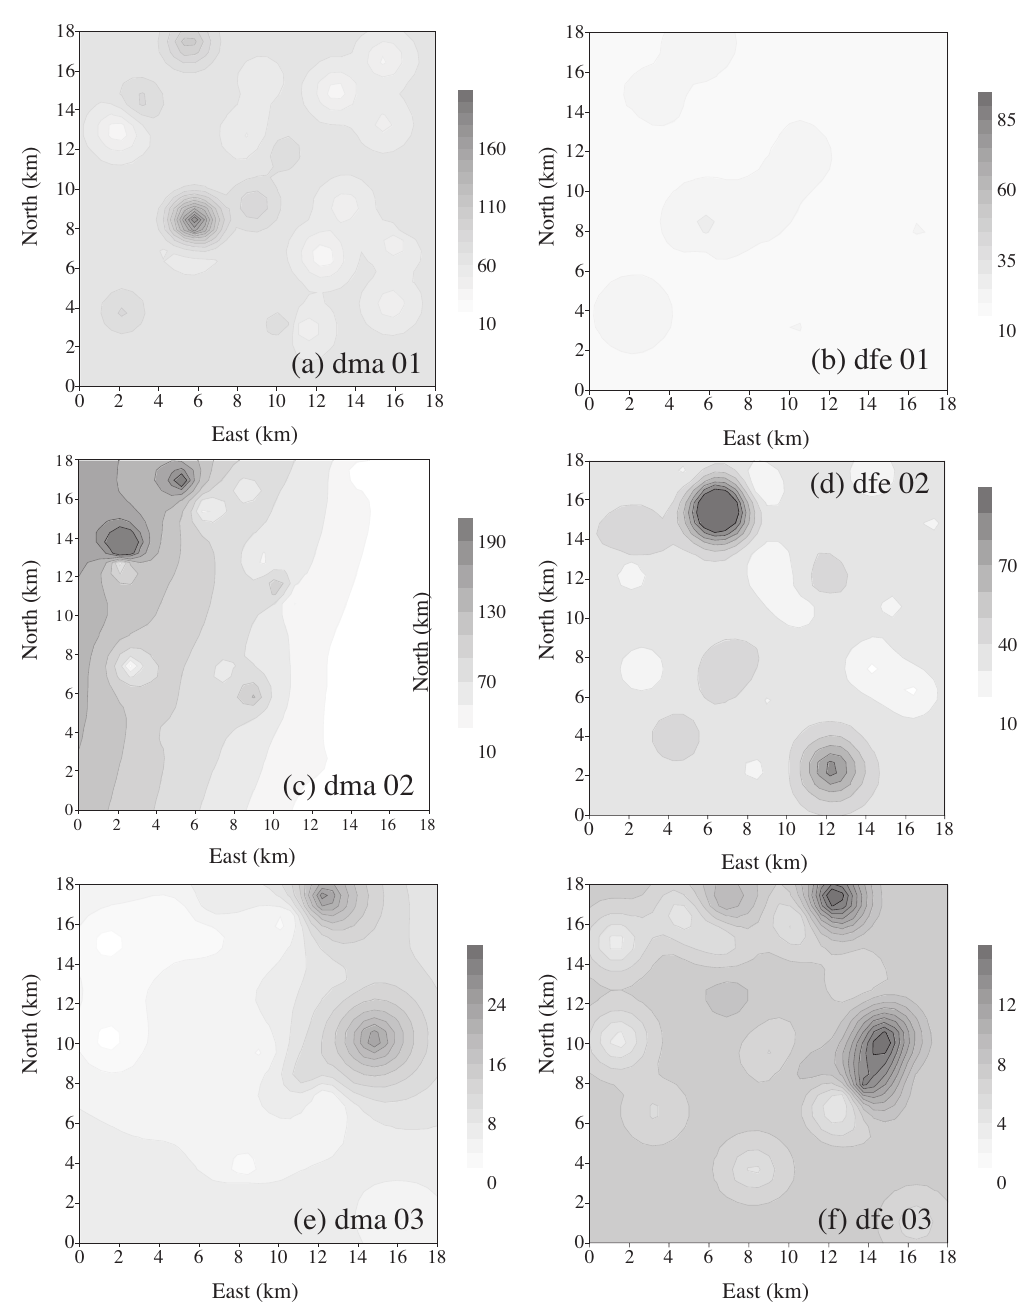
F IG . 7. – Density of dab biomass (cpue, kg 30 min -1 ) for males, dma (a, c, e) and females, dfe (b, d, f) during cruises 2001-2003 (with star survey design) within box A. Estimations with ordinary kriging based on models fitted to annual structures. For dfe and dma in 2001 the model fitted to the generic semivariogram was used for